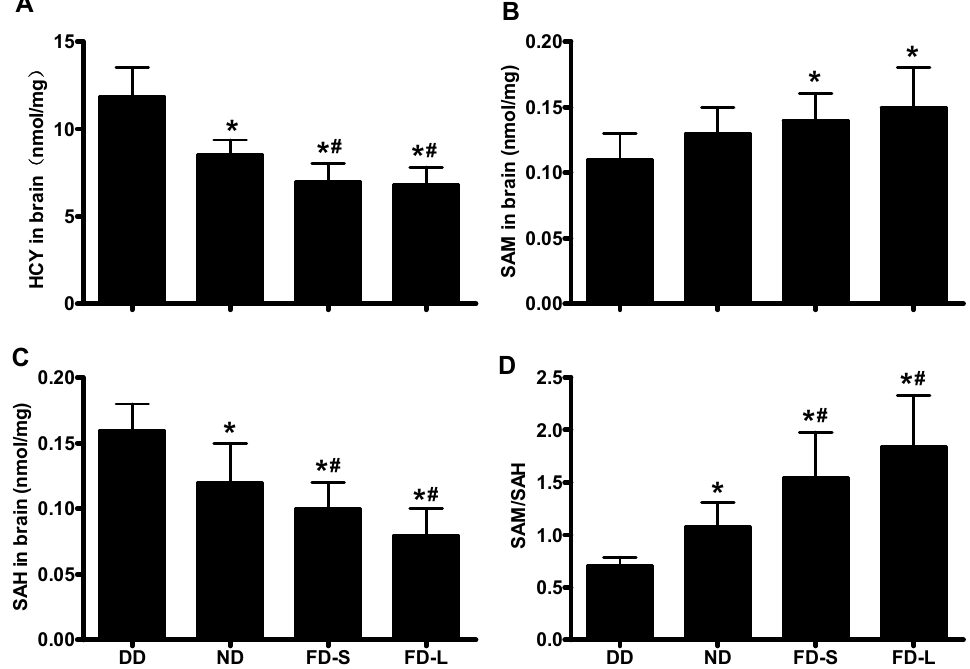
Figure 3. Maternal folic acid supplementation altered one carbon metabolism in offspring. Dams were fed as described in Figure 1. ( A ) Brain Hcy concentration in pups; ( B ) Brain SAM concentration in pups; ( C ) Brain SAH concentration in pups; ( D ) Methylation potential (SAM:SAH ratio) in brain tissue of pups. * p < 0.05 compared with DD group. # p < 0.05 compared with ND group. Data are expressed as mean ± SD for n = 10 pups/group (same pups as Figure 2).